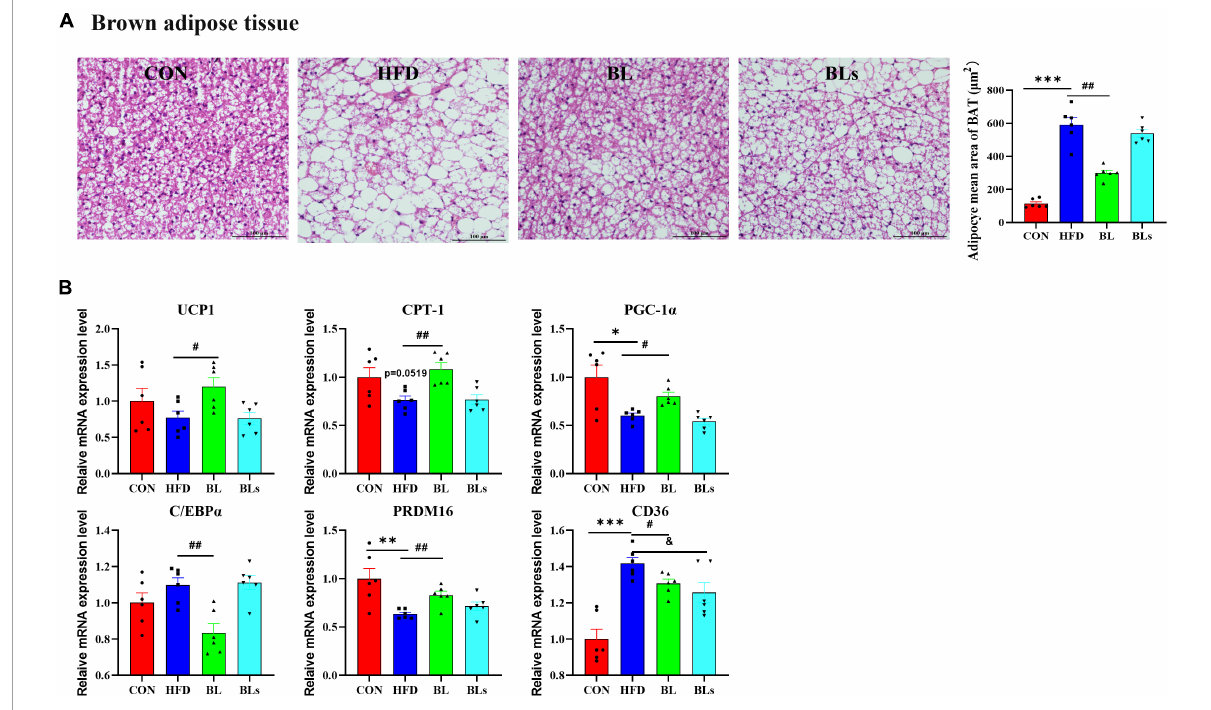
FIGURE5 Brevibacillus laterosporus BL1 treatment triggered BAT browning in HFD-fed mice. (A) H and E staining of brown adipose tissue sections, scale bar = 100 µ m, (B) relative mRNA expression levels of UCP-1, CPT-1, PGC-1 α , C/EBP α , PRDM16, and CD36 in brown adipose tissue. Data are presented as mean ± SEM ( n = 6) and analyzed using one-way ANOVA. Significant differences between HFD and CON are indicated by ∗ p < 0.05, ∗∗ p < 0.01, and ∗∗∗ p < 0.001. Significant differences between HFD and BL are indicated by # p < 0.05 and ## p < 0.01. Significant differences between HFD and BLs are indicated by & p <